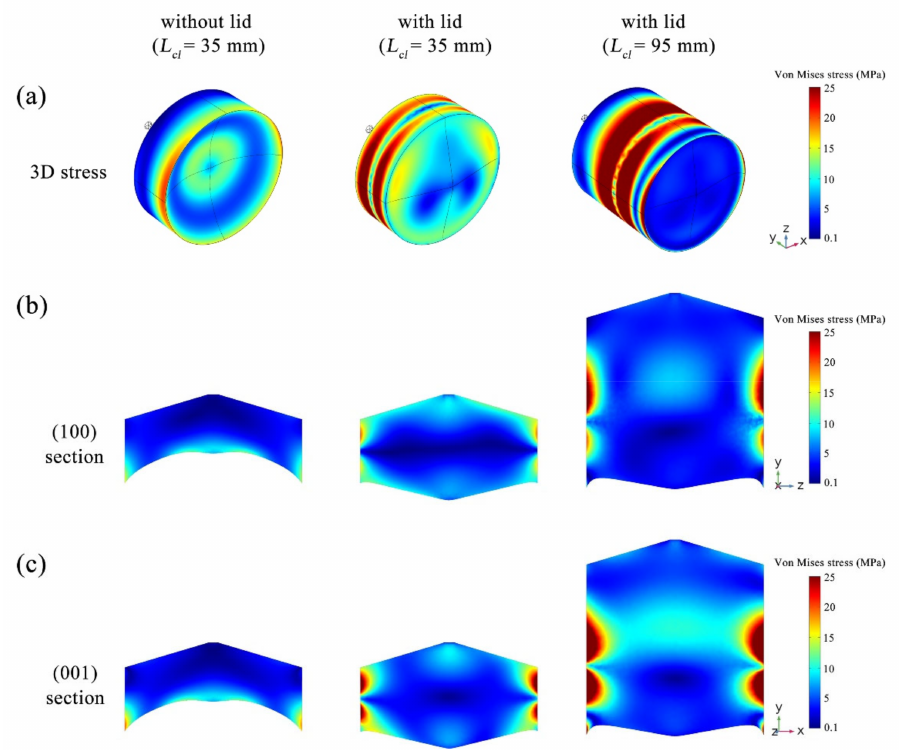
Figure 8. Von Mises stress distributions in crystals grown without an insulation lid, with an insulation lid (crystal length = 35 mm), and with an insulation lid (crystal length = 95 mm). ( a ) 3D distribution and plane distributions in ( b ) the (100) section and ( c ) the (001) section. The boundary condition of fixed constraint is added at the top surface of the